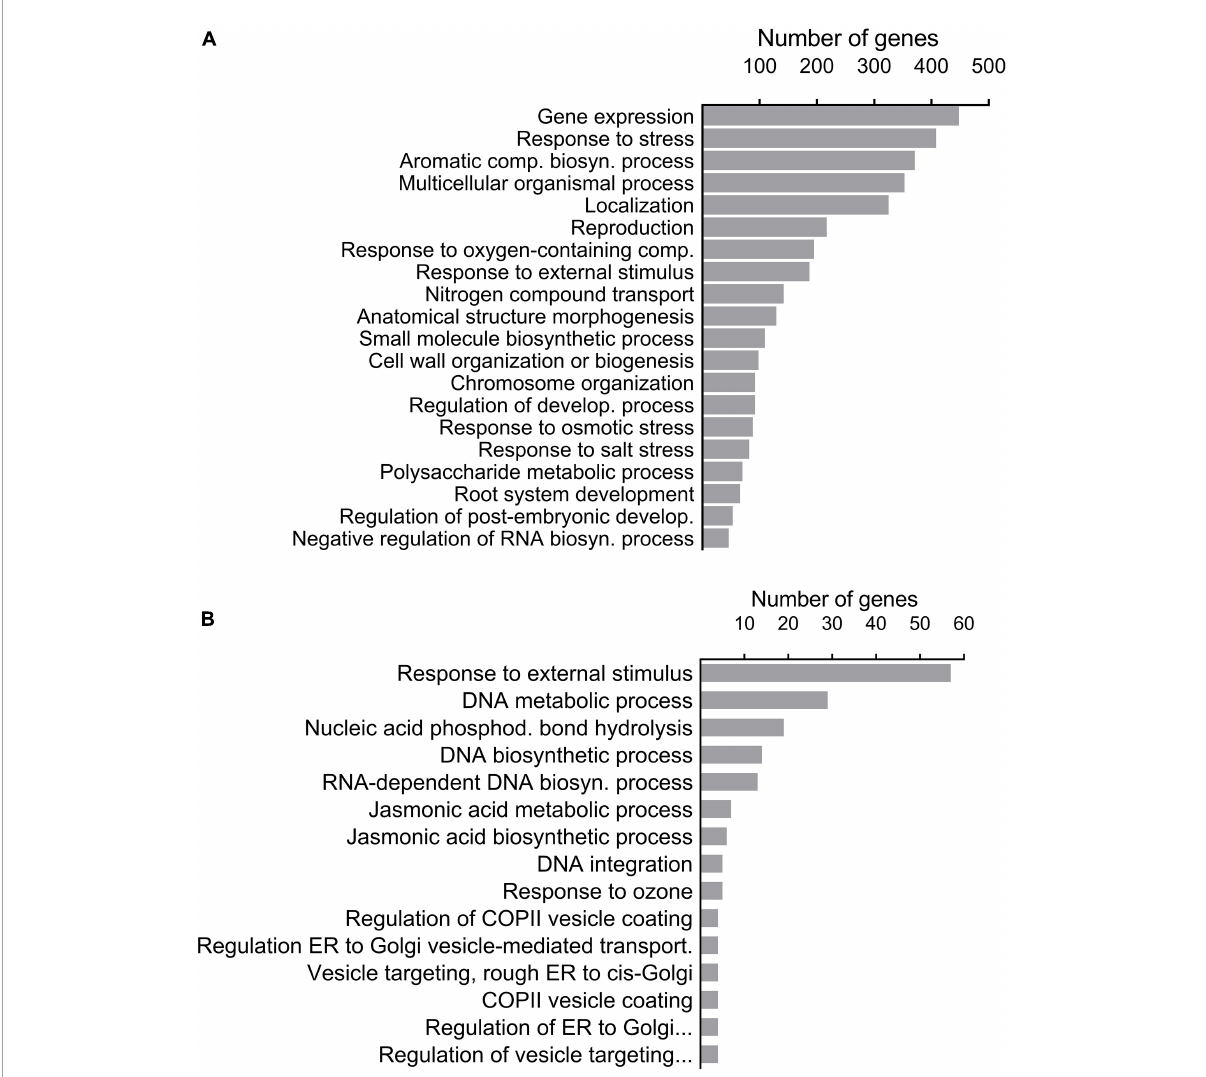
FIGURE2 GO enriched biological processes of significantly differentiated SNPs ( P < 0.05, Fisher’s exact test with FDR correction) that were screened on the basis of AF-F ST (A) and environmental parameters (B) .